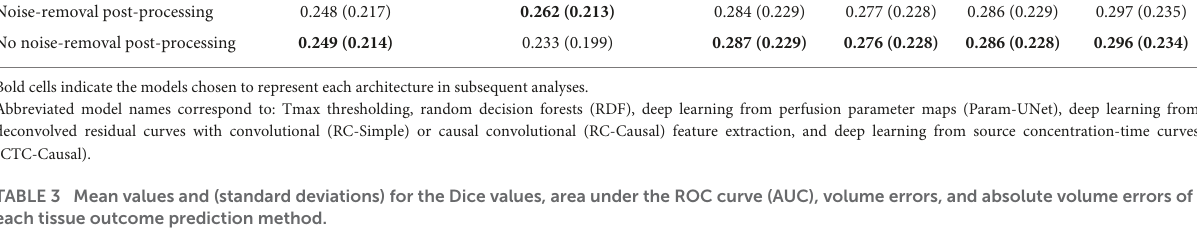
TABLE 3 Mean values and (standard deviations) for the Dice values, area under the ROC curve (AUC), volume errors, and absolute volume errors of each tissue outcome prediction method. Total IA patients IV